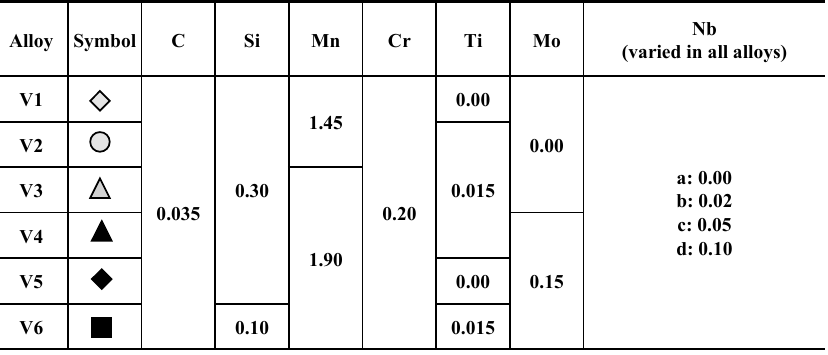
Table 1. Variation of alloy compositions in mass % subjected to heat-affected zone (HAZ) simulations (symbols refer to all subsequent diagrams).